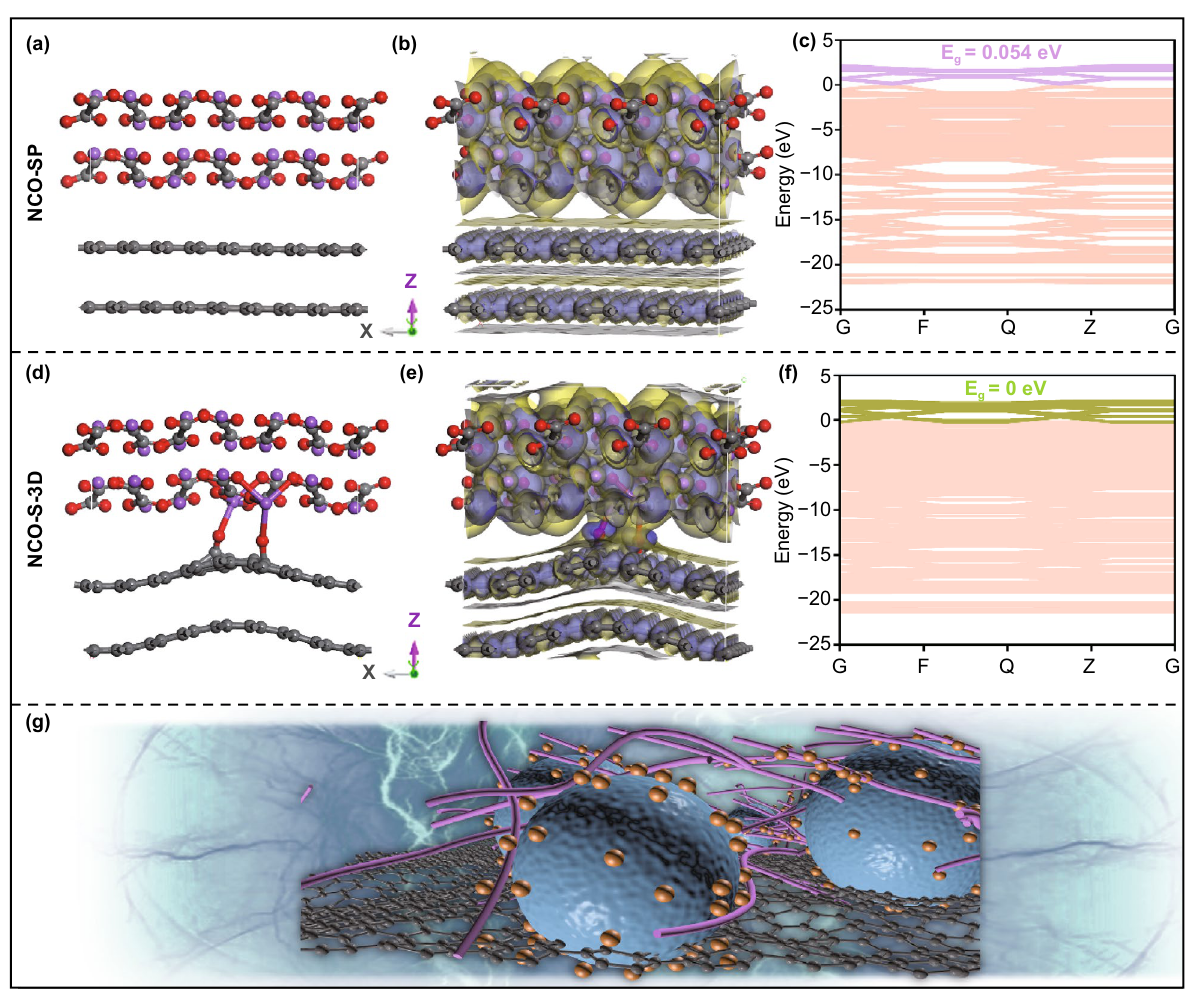
Fig. 2 a Crystal structure, b charge density difference plot and c band structure of NCO-SP. d Crystal structure, e charge density difference plot and f band structure of NCO-S-3D. g Schematic illustration of interfacial bonding between Na 2 C 2 O 4 and 3D conductive network (the orange ball, purple tube, black ball and blue ball represent carbon dot, carbon nanotube, graphene and sodium oxalate,